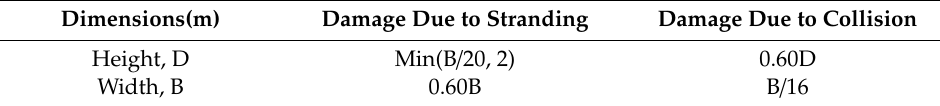
Table 3. Location and dimensions of the damage [10].